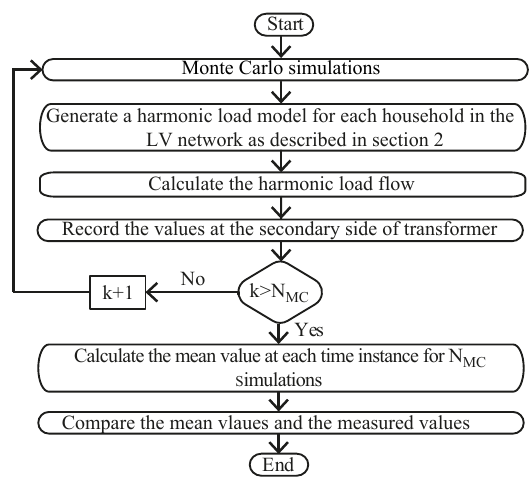
Figure 9. The flow chart of the comparison between simulation and measurement